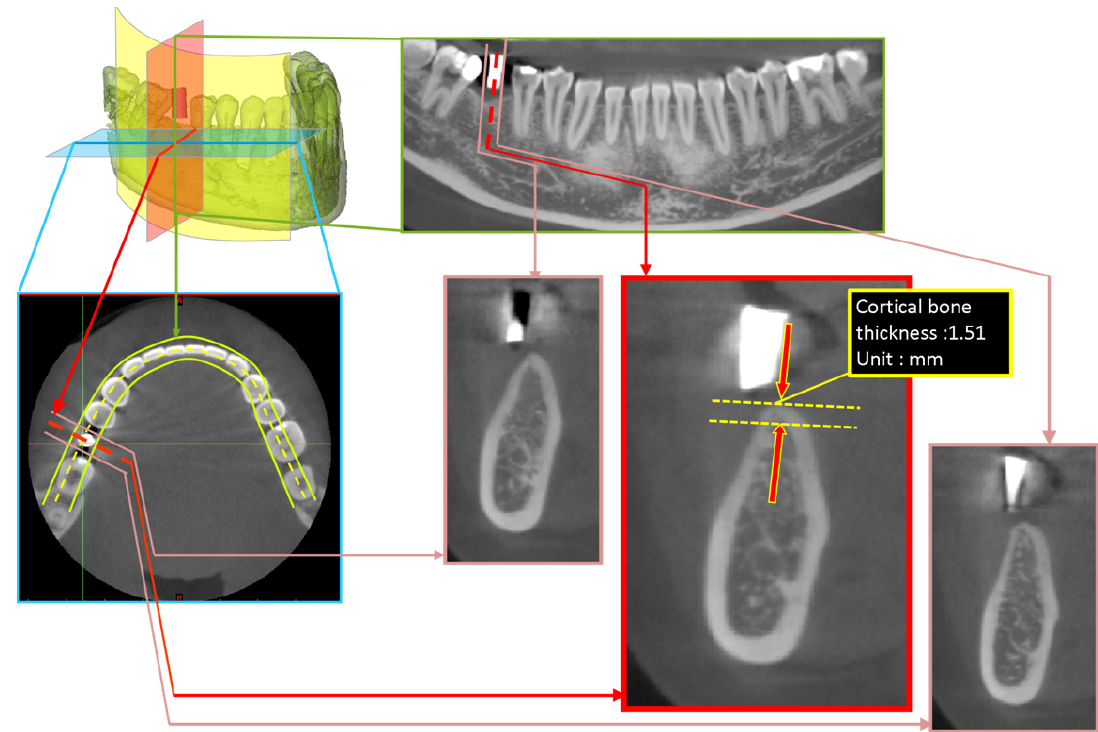
Figure 1. Measurement of cortical bone thickness at dental implant site.